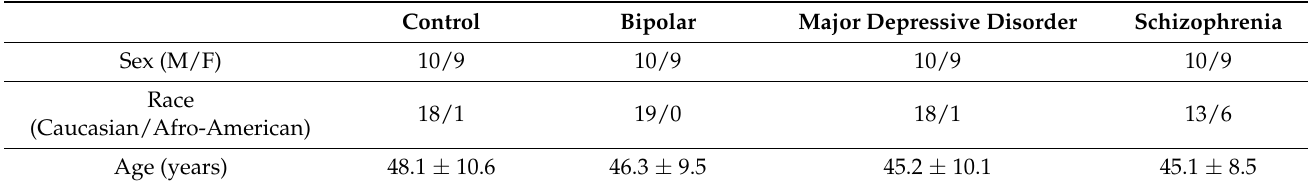
Table 1. Clinical data of patients included in